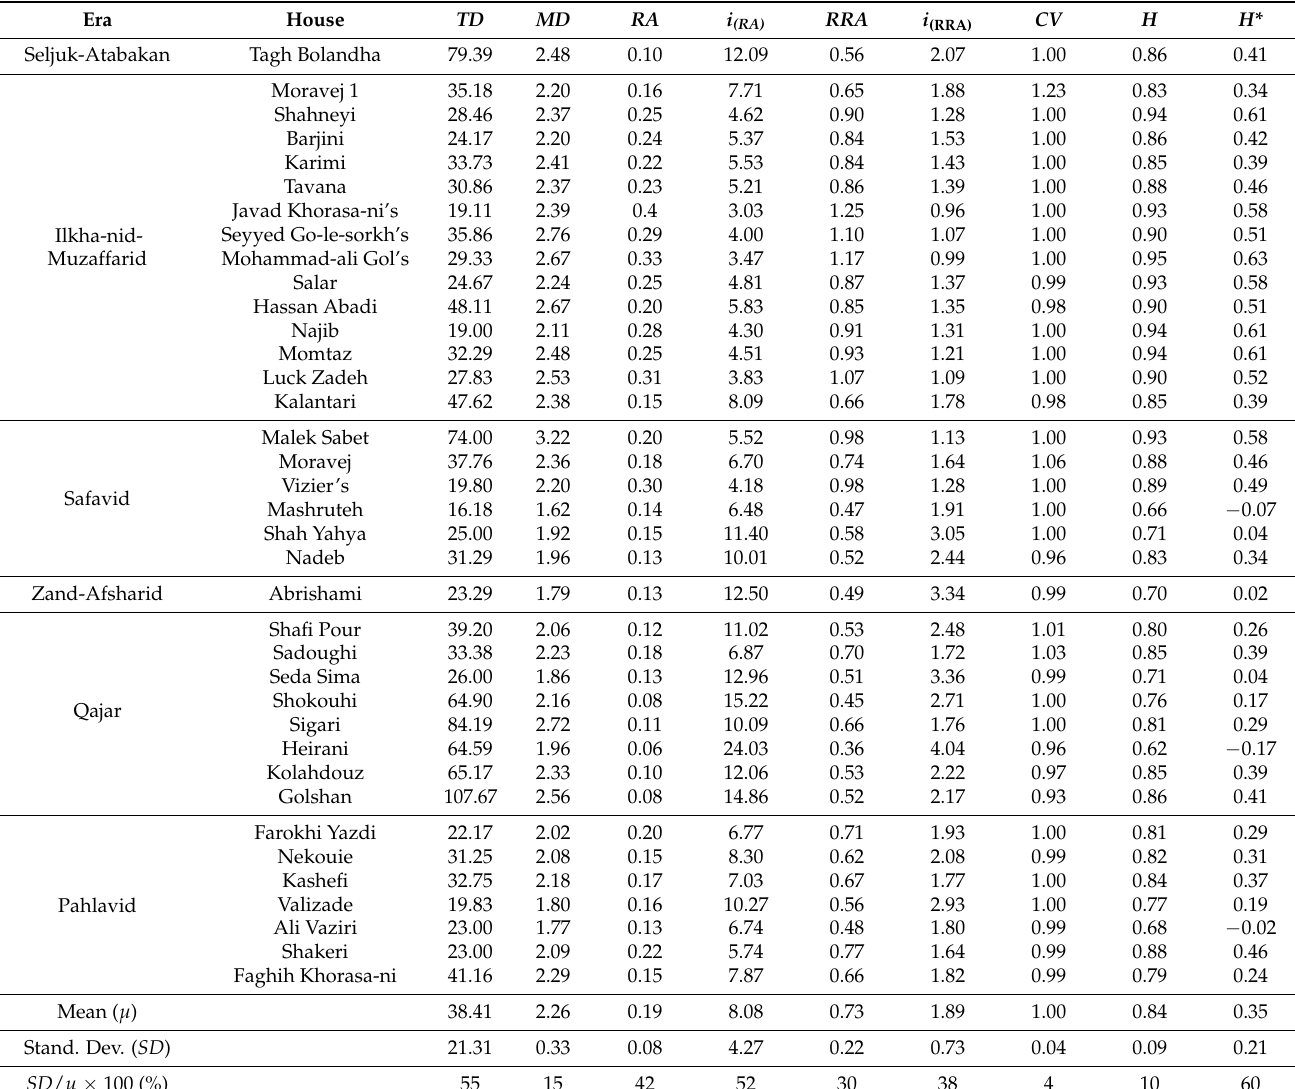
Table 4. Results per house: mean for TD, MD, RA, i, RRA, i (RRA) and CV and holistic result for H and H* . Era